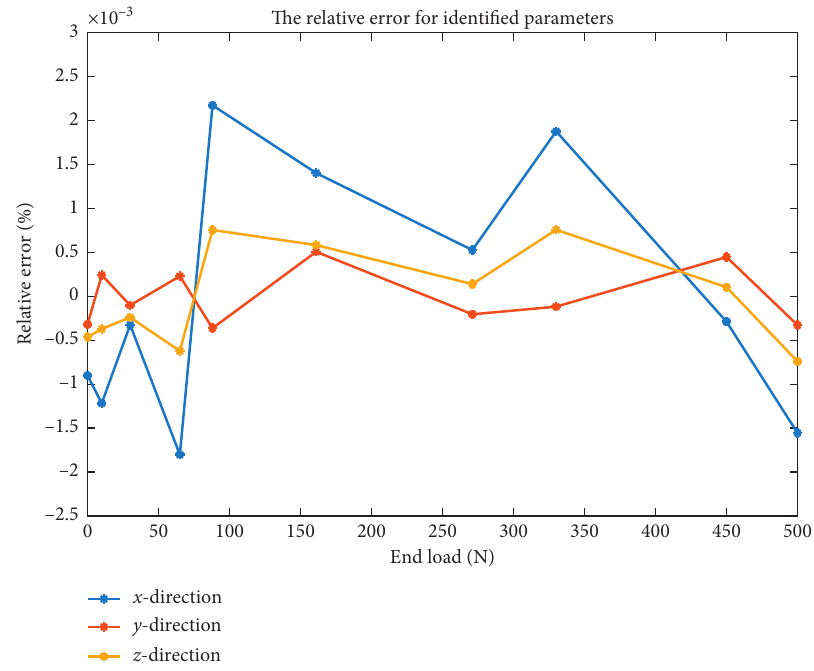
Figure 6: The accuracy of identified parameters.